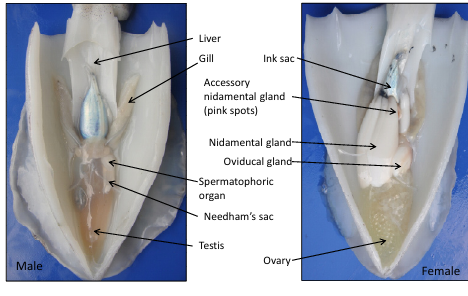
Fig. 2. Mantle cavity of (a) male and (b) female squid S. lessoni- ana showing the reproductive